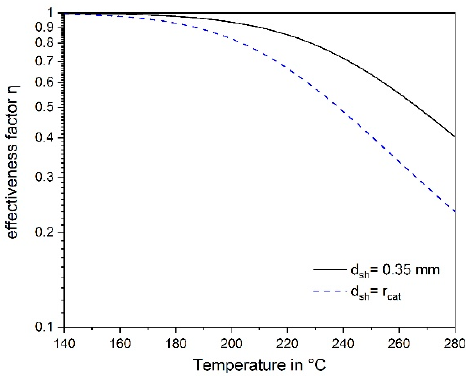
Figure 7. Influence of temperature on the effectiveness factor with regard to pore diffusion of CO methanation for a “full” and the egg shell catalyst used in this work (0.5% CO, 55% H 2 , p = 1 bar).